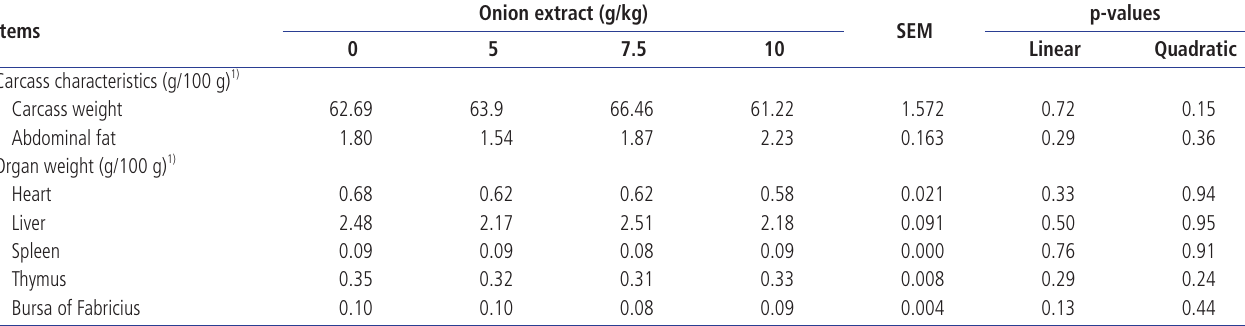
Onion extract (g/kg)